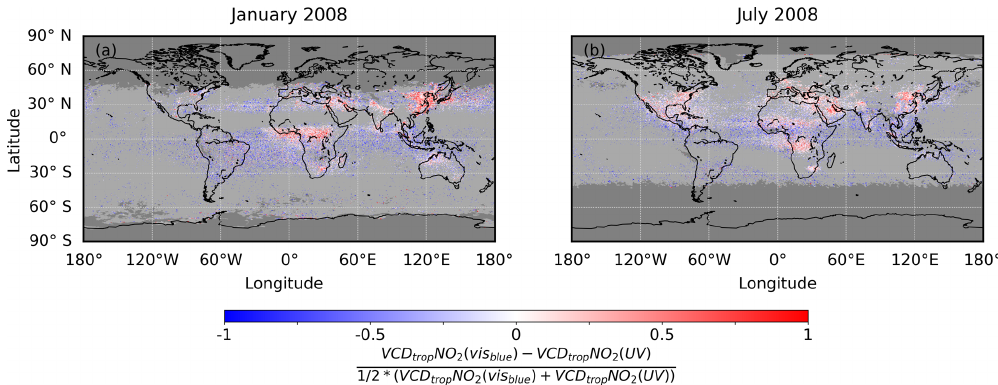
Figure 14. Relative difference between monthly mean tropospheric NO 2 VCDs in the UV and blue spectral range. Differences for (a) January and (b) July 2008. Dark grey shaded area: no NO 2 values available. Light-grey-coloured values indicate values which are filtered out. The same filter as for Fig. 8 is used.